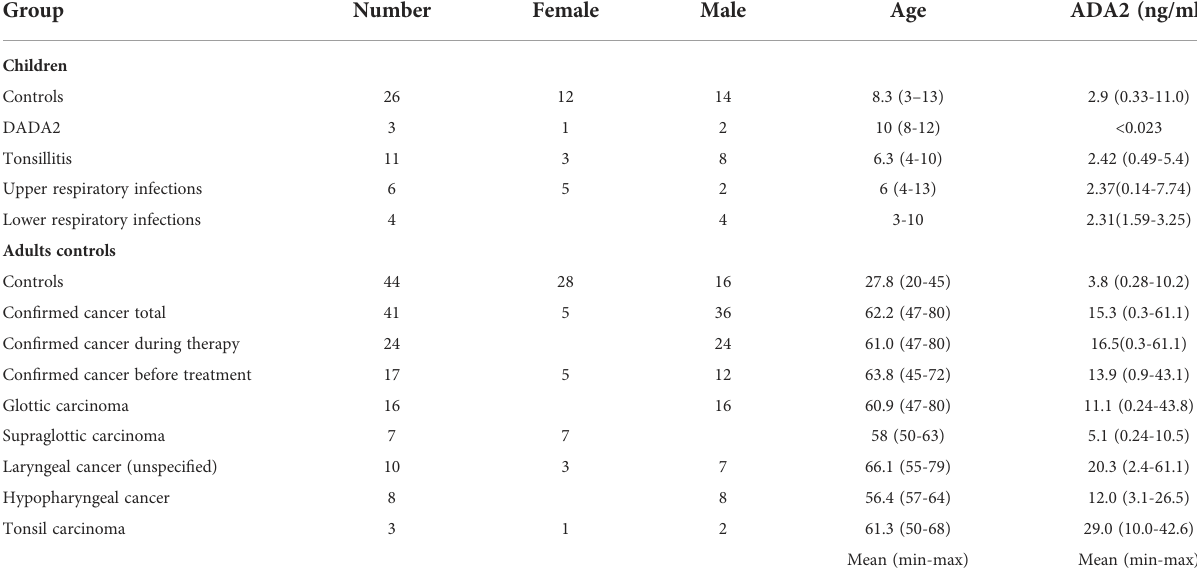
TABLE 2 ADA2 concentration in saliva of different groups of patients and healthy controls. Group